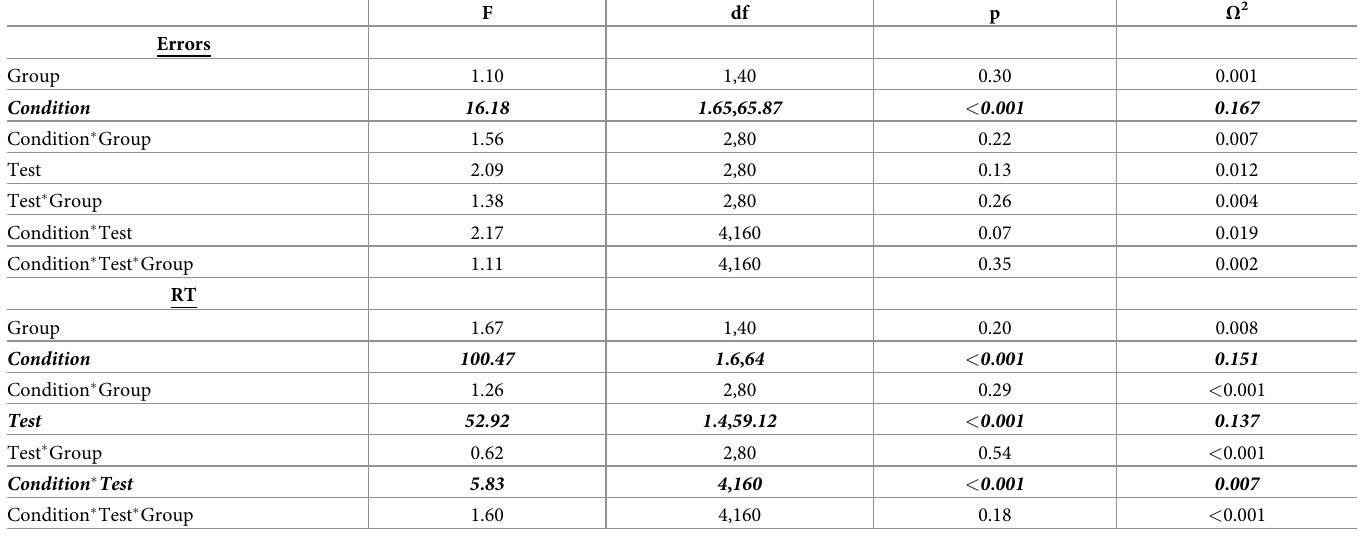
Table 2. ANOVA results of Stroop task